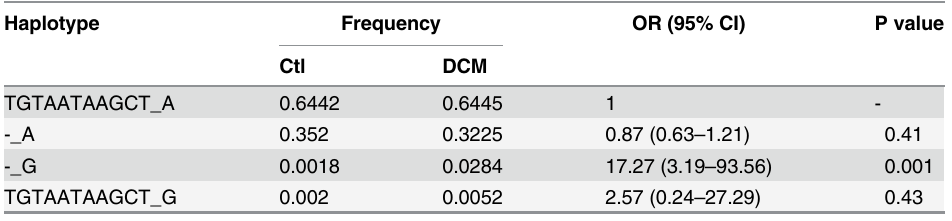
Table 4. Haplotype Analysis in DCM Patients vs Control